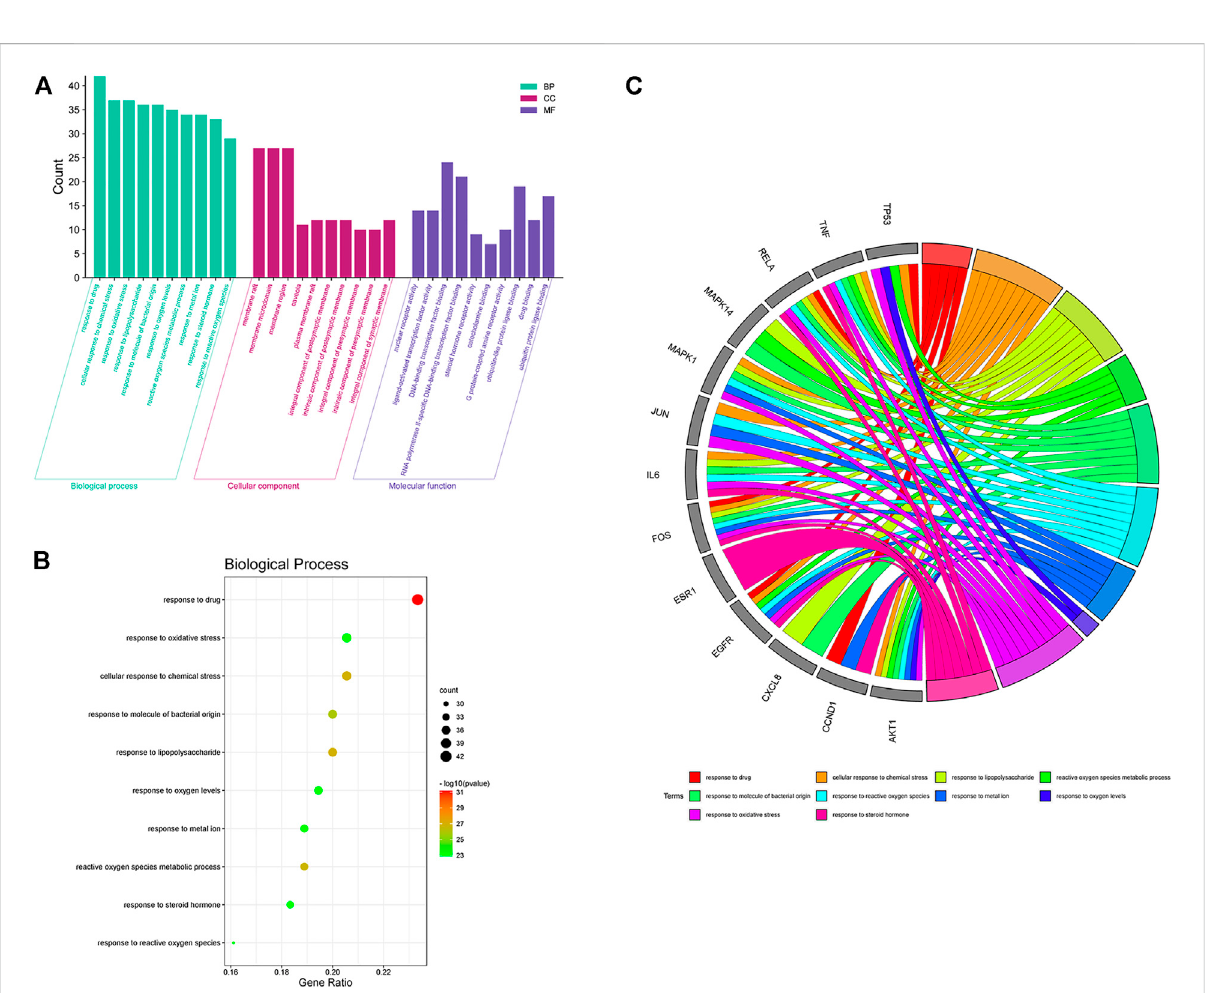
FIGURE 6 Gene Ontology (GO) function enrichment analysis of PD in the treatment of colon cancer. (A) GO function analysis, including BP, CC, and MF. (B) bubble diagram of BP enrichment. (C) GO chord diagram of the top 10 BP in the PD anticolon